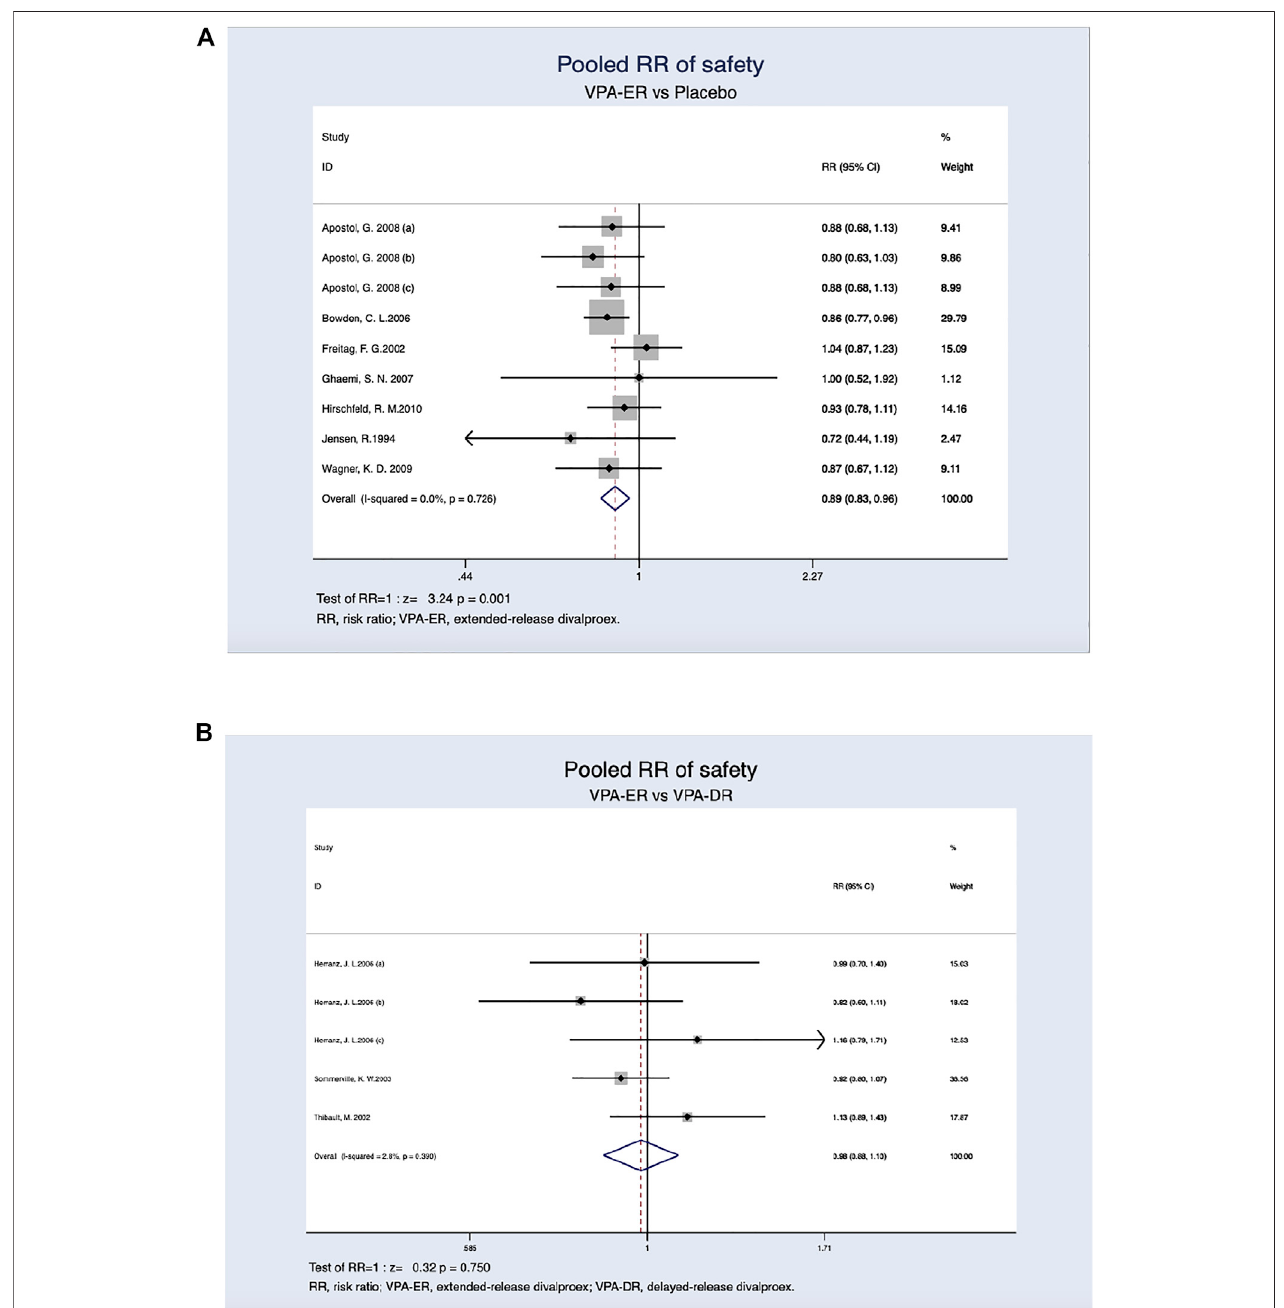
FIGURE 4 | (A) Pooled RR of safety between VPA-ER with placebo. (B) Pooled RR of safety between VPA-ER with VPA-DR.